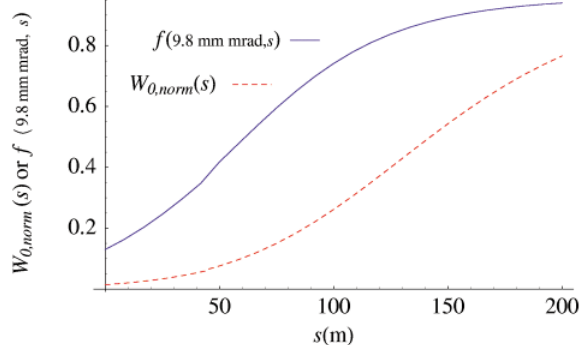
FIG. 6. (Color) Normalized peak density, as defined in Eq. (13.2), and fraction of the distribution within 9.8 mm rad (geometric four-dimensional emittance), from Eq. (10.19), as a function of distance along the channel.